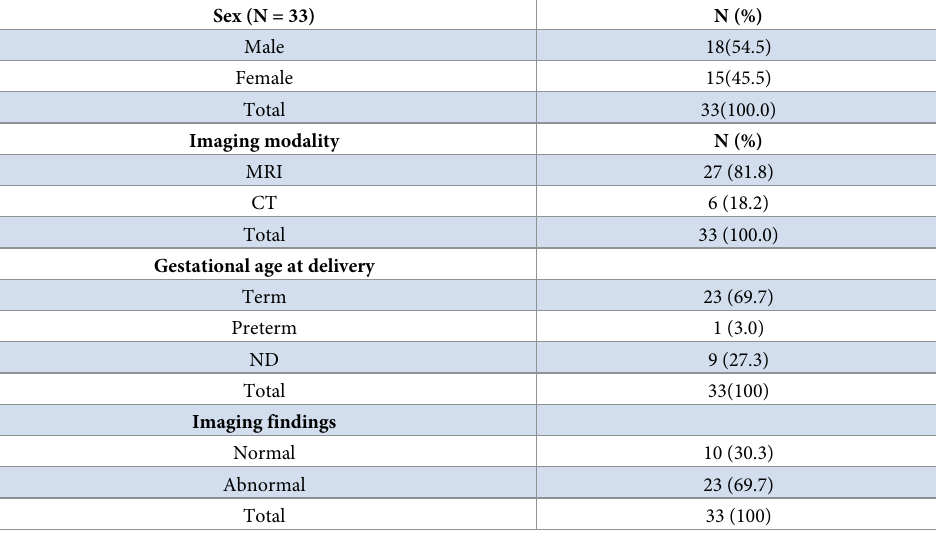
Table 2. Characteristics of pediatric patients with cerebral palsy who underwent neuroimaging at ACSH between January 2016 and August